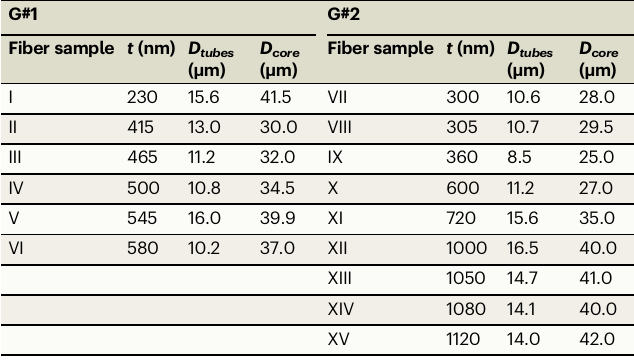
Table 1 | G#1 and G#2 fi bers ’